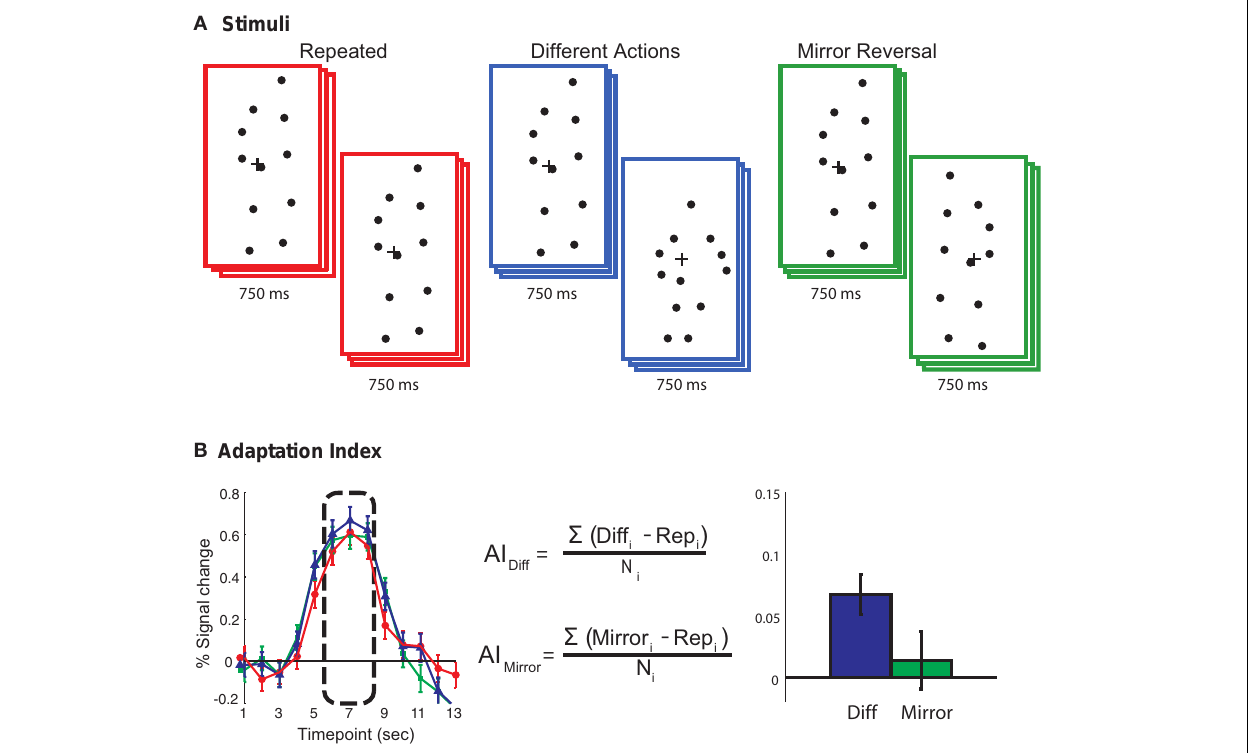
FIGURE 1 | (A) Schematic of stimuli. Subjects viewed 750 ms point-light animations, separated by a short interstimulus interval (250 ms in Experiments 1 and 2, 50 ms in Experiments 3 and 4). (B) Adaptation indices were computed from the three timepoints at the peak of the hemodynamic response, as the average increase in BOLD response relative to the Repeated